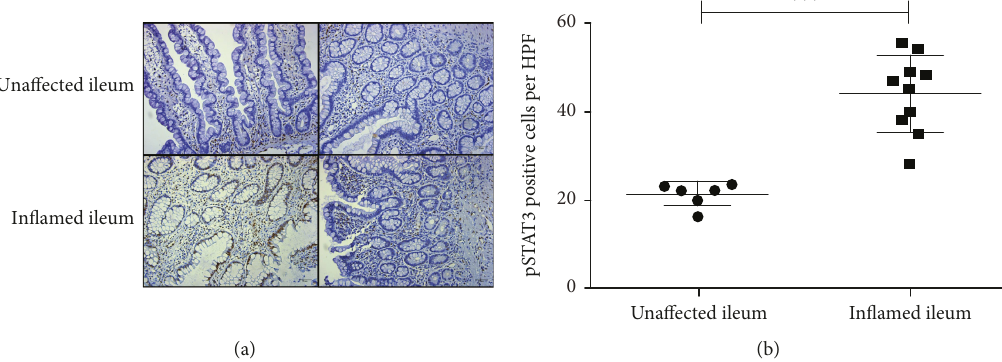
Figure 3: Increased activation of STAT3 signaling in the in fl amed ileum of Crohn ’ s disease patients. (a) Representative images of pSTAT3- Y705 IHC staining on una ff ected ( n = 6 ) and in fl amed ileum of CD patients ( n = 10 ). pSTAT3 + cells were shown as brown dots. Images were obtained under 20x magni fi cation. Scale bar = 50 μ m . (b) Statistical analysis of pSTAT3-Y705 + cells per HPF in una ff ected and in fl amed ileum of CD patients. Unpaired Mann-Whitney t test was performed, α = 0 05